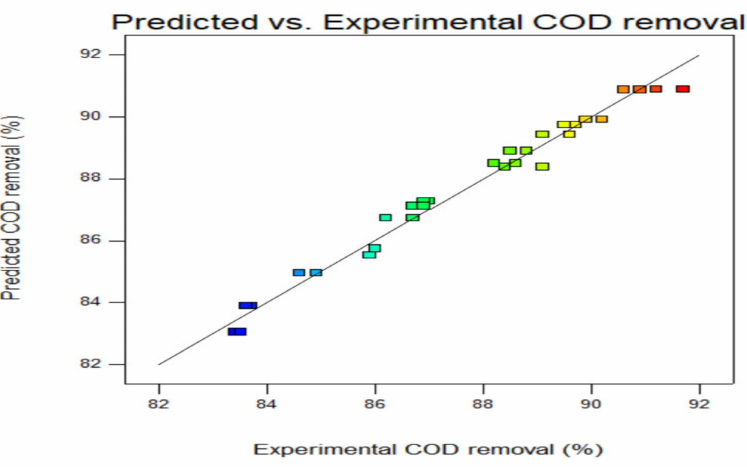
Figure 2. Predicted vs. experimental COD removal values.